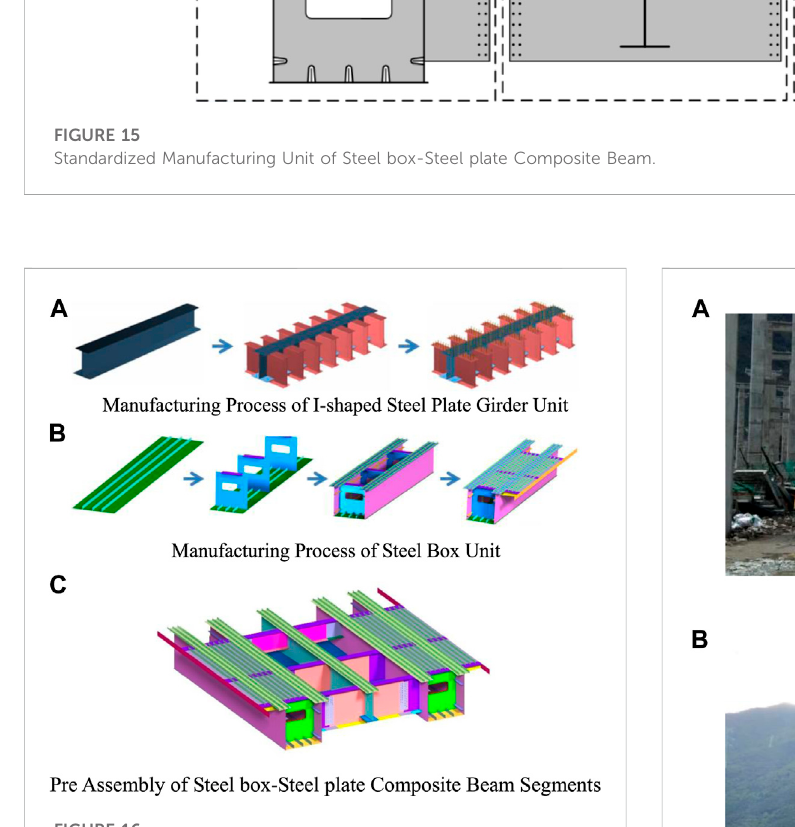
FIGURE 16 Manufacturing Diagram of Steel box-Steel plate Composite Beam Unit.